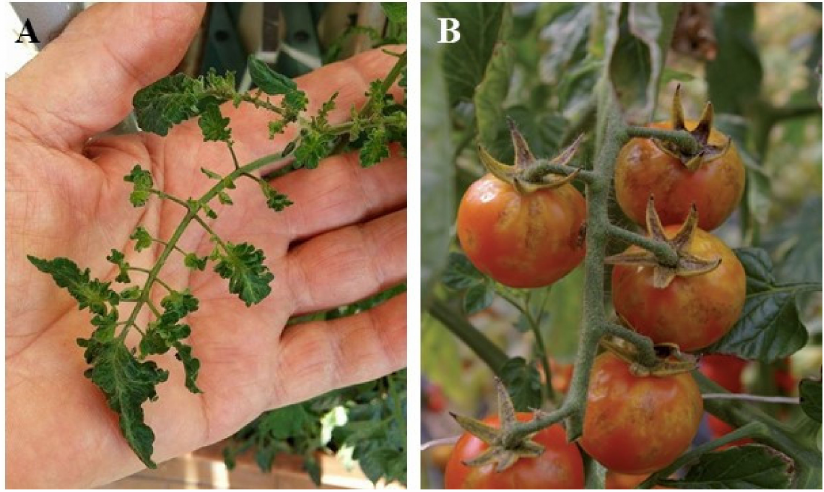
Figure 16. Severe symptoms induced by Pepino mosaic virus on leaves. ( A ) Leaflets with reduced and incised flap. ( B ) Fruits with blotchy ripening and